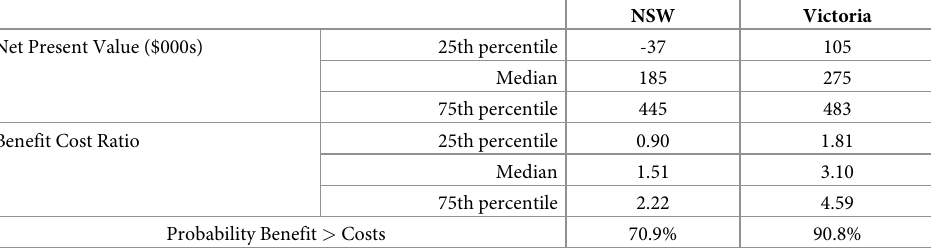
Table 4. Results of simulations of Net Present Value (NPV) and Benefit Cost Ratio per farm. NPVs are in